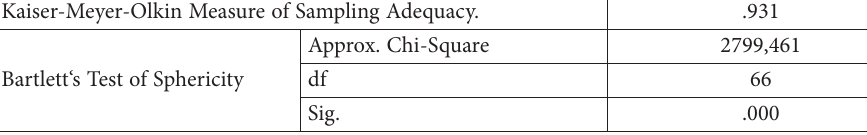
Table 3. KMO and Bartlett’s test (source: own research) Kaiser-Meyer-Olkin Measure of Sampling Adequacy.